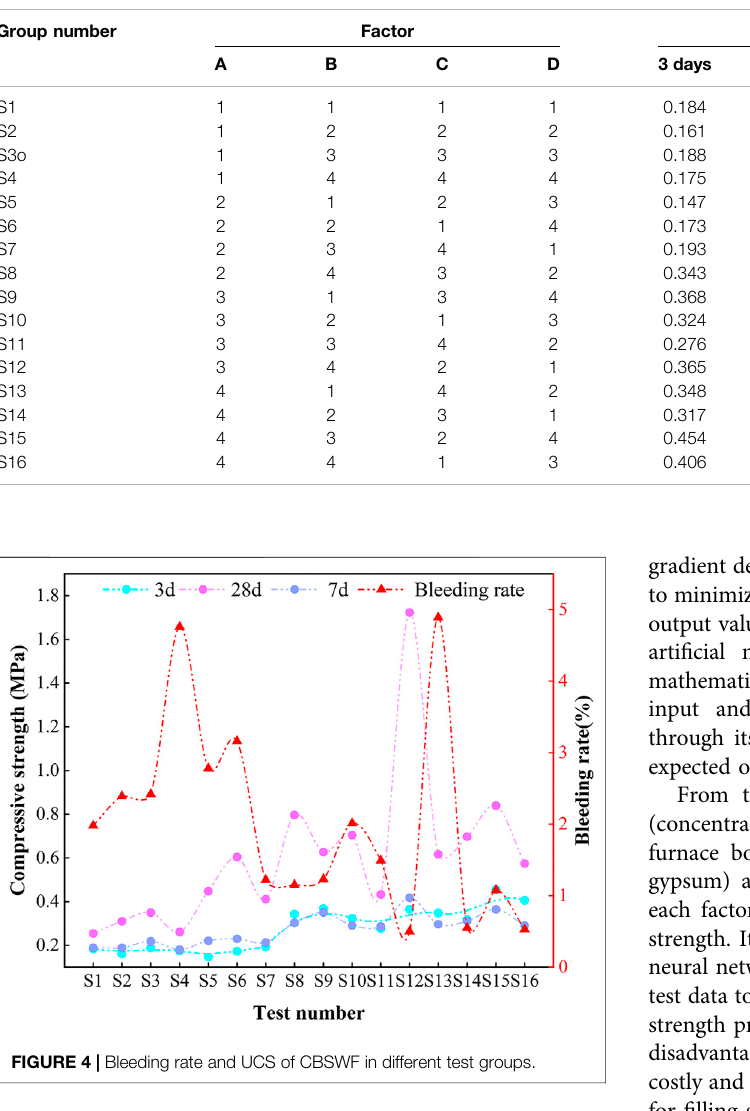
TABLE 2 | Orthogonal experimental results of L16 (4 4 ) CBSWF.